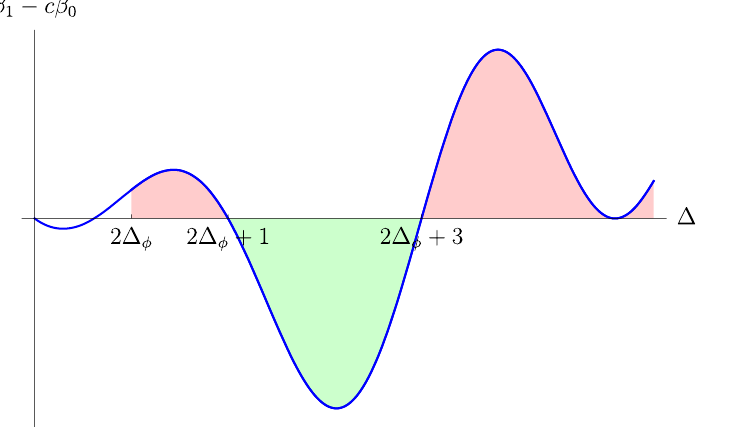
Figure 3 . Spectrum of the solution saturating OPE maximization bound at (cid:1) (cid:1) (cid:30) = 1 = 2. (cid:14) (cid:1) n (cid:17) j (cid:1) n (cid:0) (cid:1) B j . Left: using the fermionic functional basis, as N is increased by two n units a new operator appears with initial bounded absolute error in dimension, which converges to about (cid:24) 0 : 6 at large N . As N increases further this error then rapidly decreases. Right: convergence of scaling dimension (cid:1) . In red the derivative basis, in blue the functional basis. The lines represent 1 (cid:12)ts to a 1 =N and 1 =N 2 behaviour respectively.